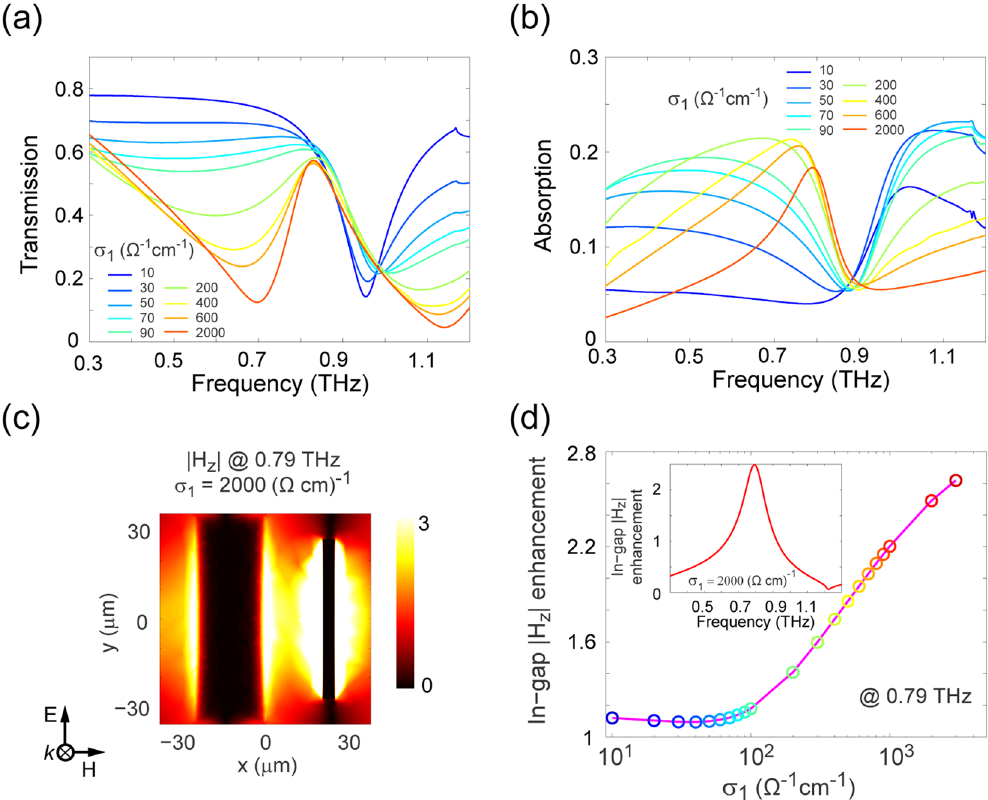
Figure 3. Asymmetric VO 2 /Au double-bar resonator based hybrid metamaterial for a tunable THz Fano resonance. Simulated ( a ) transmission and ( b ) absorption spectra of the hybrid metamaterial for a series of conductivity values σ 1 . ( c ) Magnetic field distribution at 0.79 THz when σ 1 = 2000 Ω − 1 cm − 1 . ( d ) The in-gap |H z | enhancement as a function of σ 1 at 0.79 THz. The case for σ 1 = 2000 Ω − 1 cm − 1 as a function of frequency is shown in the inset. All data for |H z | was normalized to the magnetic field magnitude of the incident